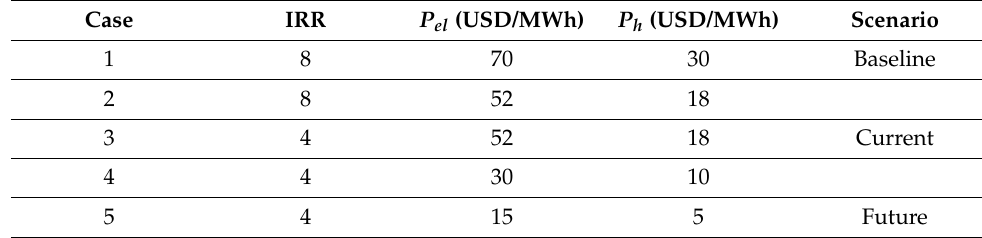
Table 4. Different scenarios for